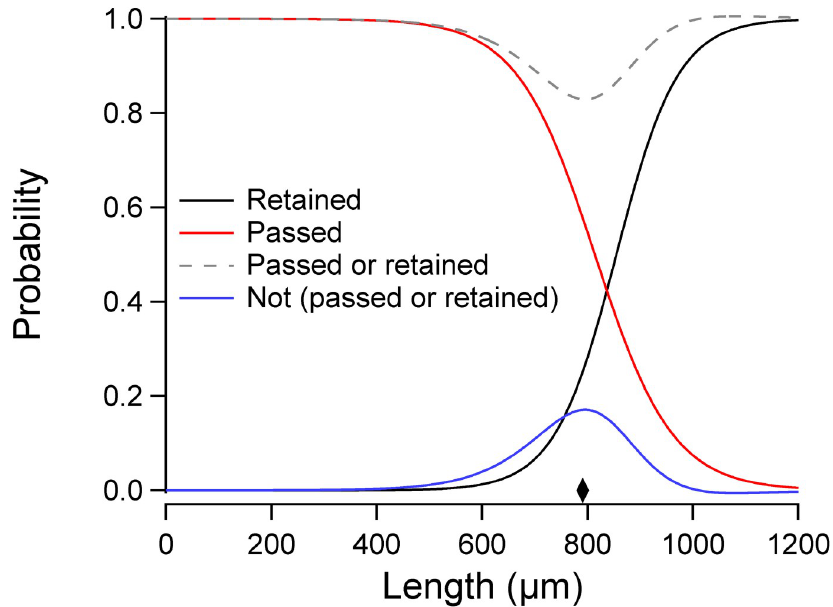
Fig 7. Non-ideal properties of 1-step filtration. The black and red traces are the filter functions for 1-step retention, 40 μ m (Fig 4B) and 1-step passage, 40 μ m (Fig 4C), respectively. In the ideal case, the sum of filter functions for retention and passage by the same filter should equal 1. However, for the 40 μ m cell strainer it does not ( gray dashed trace ). The probability of being neither passed nor retained ( blue trace ) is maximal at 795 μ m, a length corresponding to a width of 40.2 μ m ( diamond ) which is close to the mesh size. This finding suggests that worms having a width approximately equal to the mesh size have a higher probability of being captured by the mesh than wider or narrower